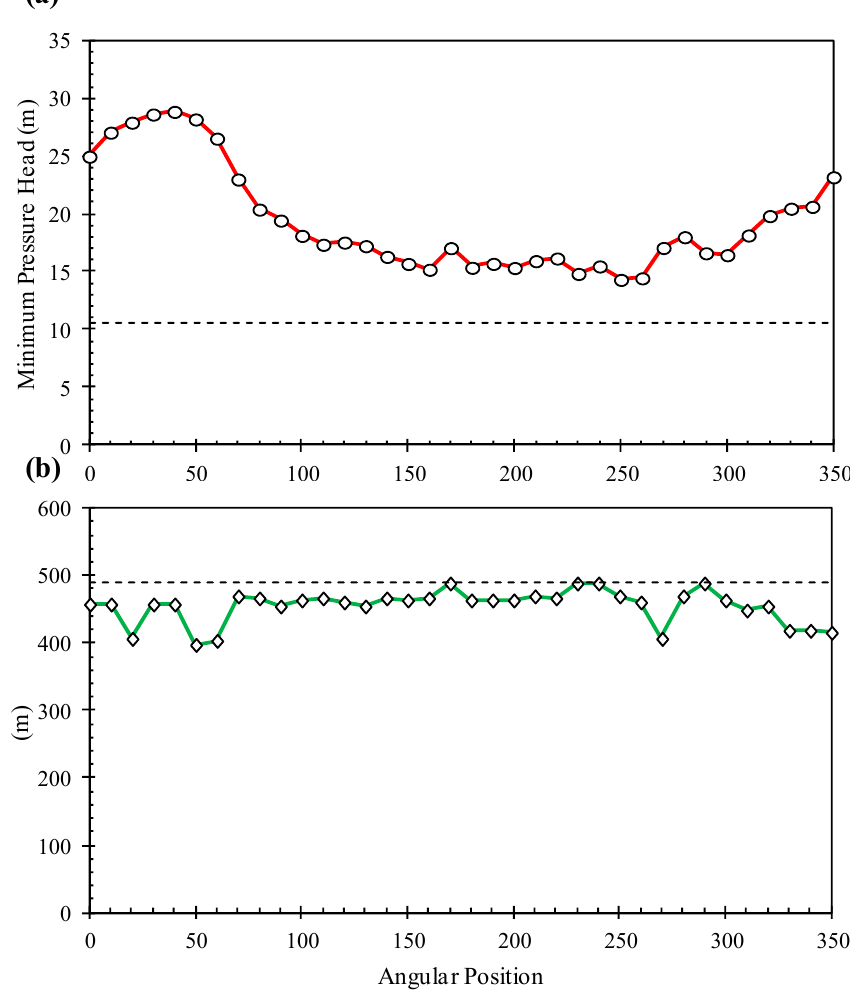
Figure 6. ( a ) Value and ( b ) location of the point of minimum pressure head in the different angular positions of the center pivot lateral